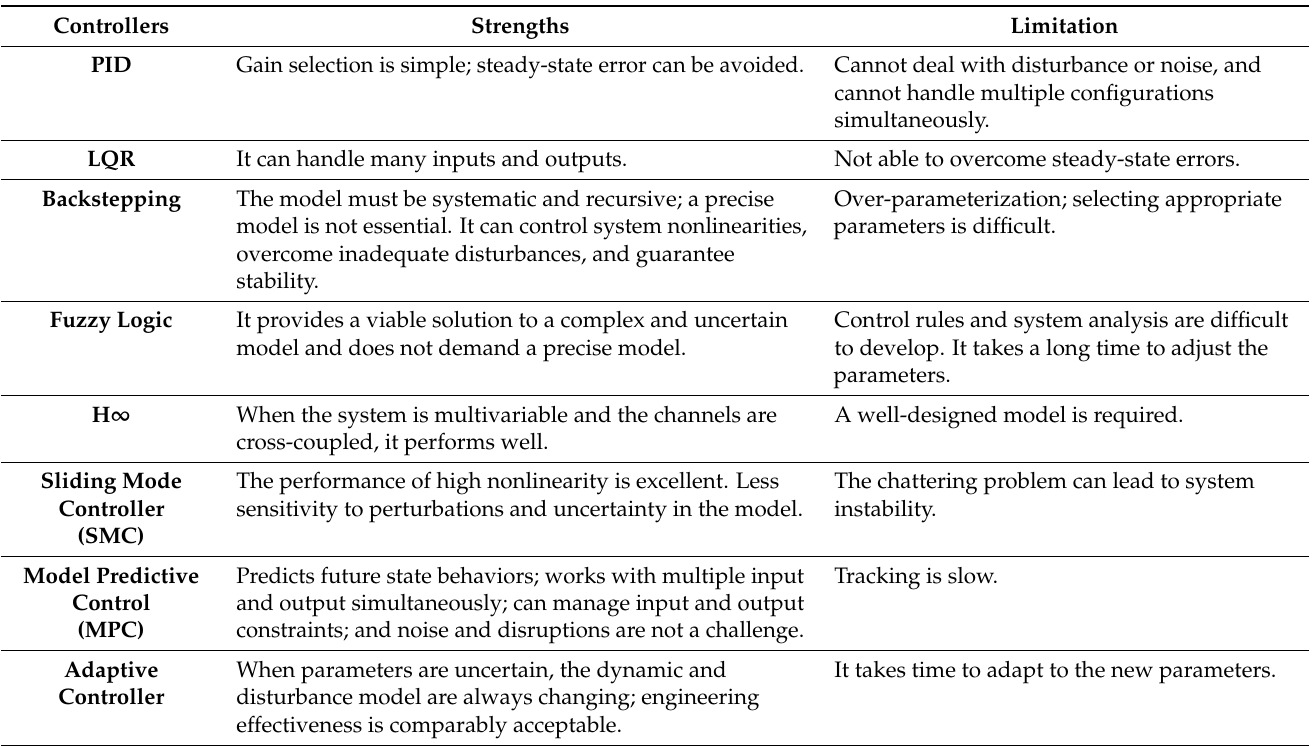
Table 1. Strengths and Limitations of Quadrotor Control